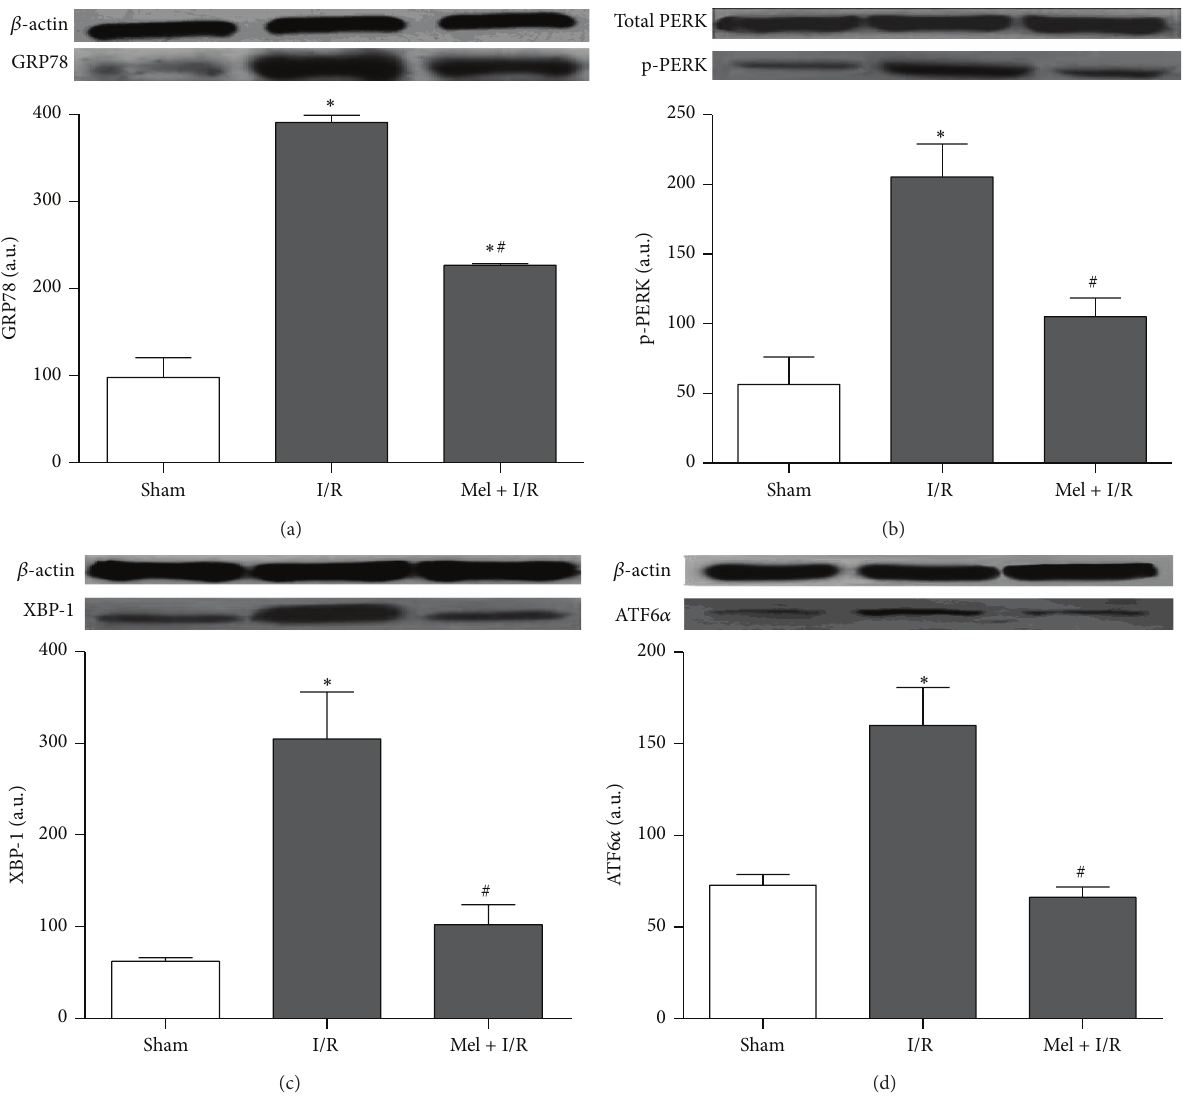
Figure 3: Western blot of GRP 78 (a), total and phosphorylated PERK (b), XBP-1 (c), and ATF6 𝛼 (d). 𝛽 -actin was used as a loading control. One representative blot of six independent experiments is shown at the top whereas densitometric analysis is shown at the bottom. Results are expressed as mean ± SEM. ∗ 𝑝 < 0.05 versus Sham. # 𝑝 < 0.05 versus